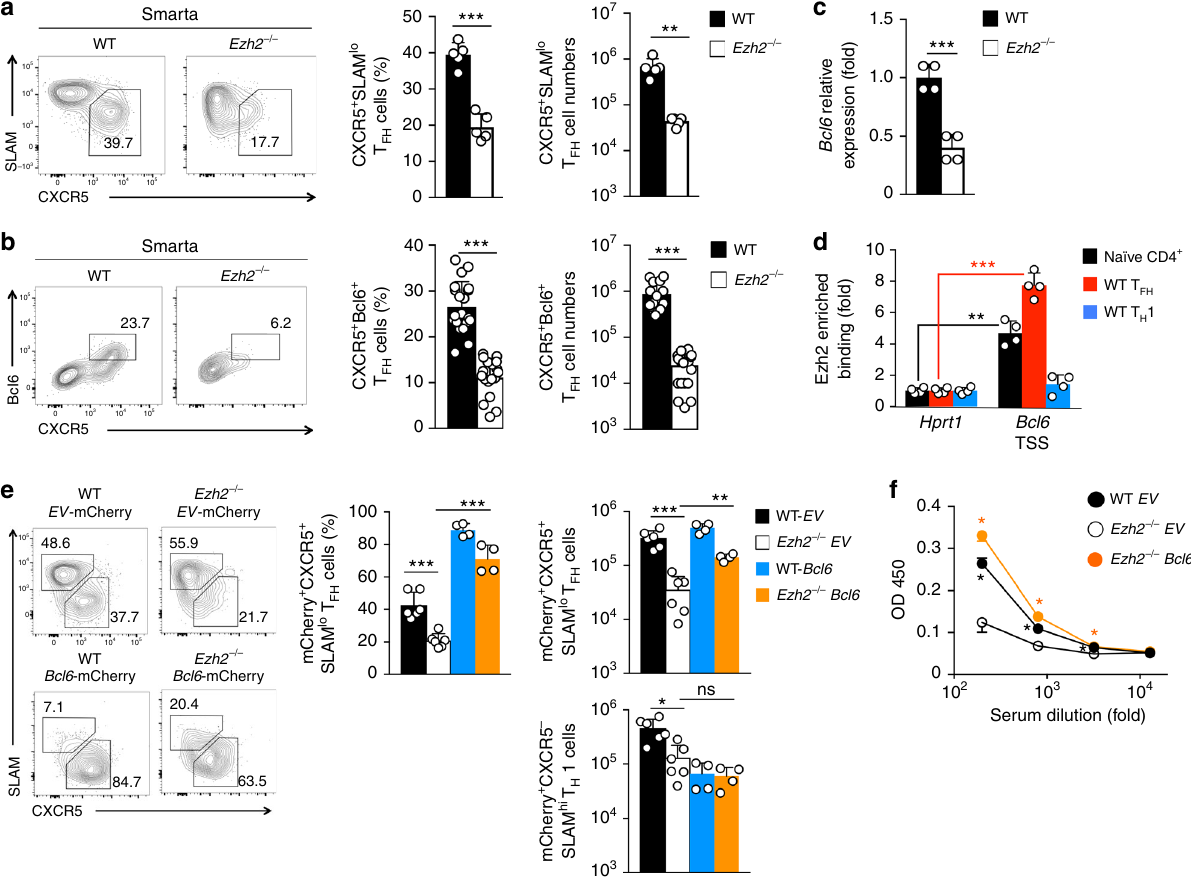
Fig. 3 Ezh2 acts upstream of Bcl6 induction to promote T FH differentiation. a – b Impact of Ezh2 de fi ciency on monoclonal CD4 + T cell responses. CD45.2 + Smarta CD4 + T cells from WT or Ezh2 – / – Smarta-Tg mice were adoptively transferred into congenic mice, followed by infection with LCMV-Arm. On 4 dpi, CXCR5 + SLAM lo ( a ) and CXCR5 + Bcl6 + T FH cells ( b ) were detected in recipient spleens. Contour plots are representative of ≥ 2 experiments, and cumulative data on frequency and numbers of each subset are means ± s.d. (each dot represents a mouse). c Detection of Bcl6 transcripts in T FH cells. CD45.2 + CXCR5 + SLAM lo T FH cells were sorted from the recipient spleens on 4 dpi as in ( a ), and Bcl6 transcript was detected by quantitative RT-PCR. d Detection of Ezh2 binding to the Bcl6 promoter. WT CD45.2 + T FH and T H 1 cells were sorted from recipient spleens on 5 dpi , and together with WT naïve CD4 + T cells, were analyzed by ChIP with anti-Ezh2 antibody or control IgG. Enriched Ezh2 binding at the TSSs of Bcl6 or Hprt1 genes was determined by ChIP-qPCR. Data in c and d are means ± s.d. from ≥ 2 experiments. e – f Impact of forced expression of Bcl6 on T FH and antibody responses. WT or Ezh2 – / – Smarta CD4 + T cells were primed in vivo for 24 h and infected with empty vector ( EV )-mCherry or Bcl6 -mCherry retrovirus. Transduced Smarta CD4 + T cells were adoptively transferred into congenic mice, followed by LCMV-Arm infection ( e ), or into Bcl6 – / – recipients, followed by KLH-GP61 immunization ( f ). In e , mCherry + CXCR5 + SLAM lo T FH cells were detected in the recipient spleens on 3 dpi (corresponding to day 5 after initial priming), with representative contour plots and cumulative data on frequency and numbers of mCherry + CXCR5 + SLAM lo T FH cells shown. In f , KLH-speci fi c IgG was detected in the recipient sera on day 8 post-immunization. All cumulative data are means ± s.d. * p < 0.05; ** p < 0.01; *** p < 0.001 for indicated pairwise comparison by Student ’ s t -test, coupled with one-way ANOVA for multi-group